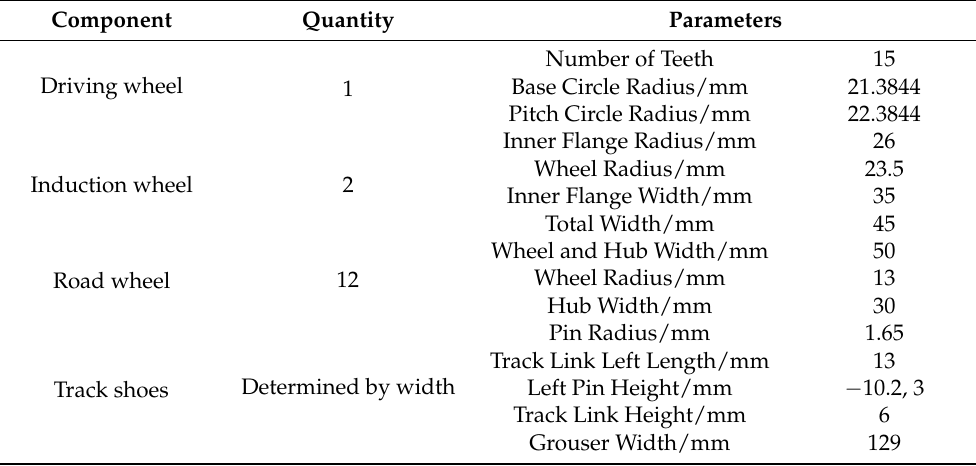
Table 1. Parameters of the main components of the walking mechanism.